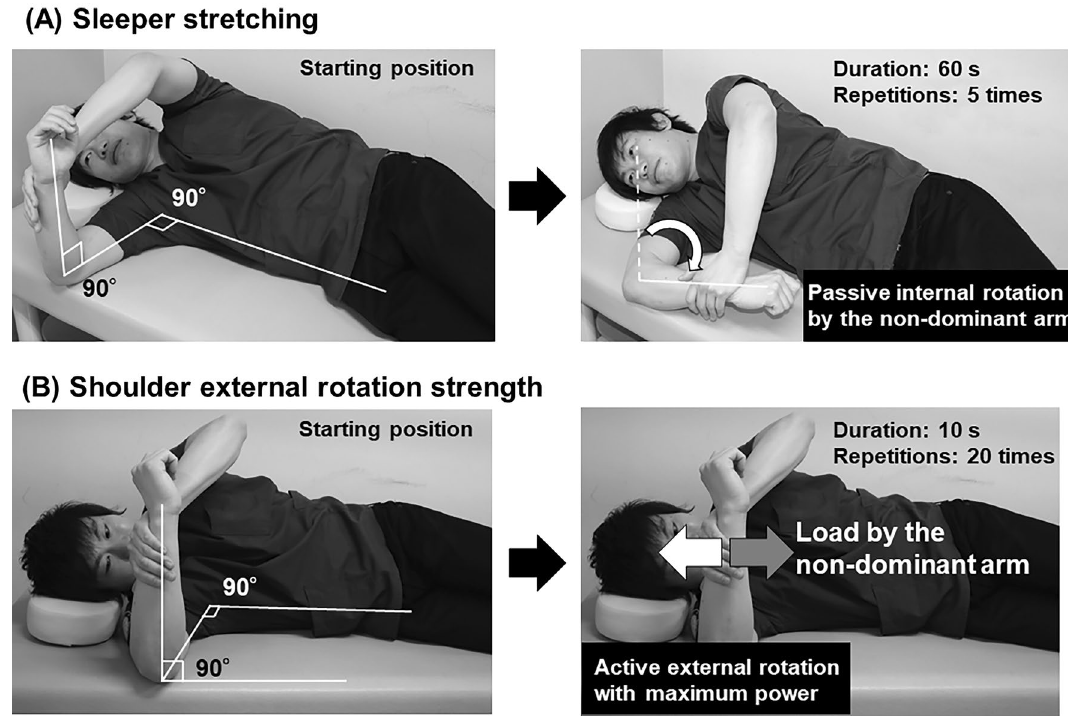
Figure 4. Prevention programs. ( a ) Sleeper stretching exercises: (1) The starting position is a dominant lateral position with the dominant scapula in contact with the bed, the dominant shoulder flexed to 90°, the dominant elbow flexed to 90°, and the dominant forearm in a neutral position. (2) The dominant forearm is grasped proximal to the dominant wrist with the non-dominant hand. (3) The dominant shoulder is passively and internally rotated by the non-dominant hand to the end of its maximum range of motion and that position is held for 1 min. (4) After a 30-s break, the stretching is repeated for a total of five times each night. ( b ) Shoulder external rotation strengthening exercises: (1) The starting position is the same as that of the sleeper stretch. (2) The dominant shoulder is maximally externally rotated for 10 s against an internal rotation force by the contralateral arm (isometric exercise). (3) After a 10-20-s break, the training is repeated for a total of 20 times each As this stretching program significantly decreased the incidence of shoulder and elbow injuries in a previous study 13 , it was used as an active control in the current study. Shoulder external rotation strength training. A modified strength training protocol focusing on the inner shoulder muscles, including the infraspinatus and teres minor 9 , and on the outer shoulder muscles, includ- ing the deltoid and the trapezius, was used as both the inner and outer muscles contribute to external rotation strength. The shoulder external rotation strengthening exercise is illustrated in Fig. 4b. The starting position is the same as that for the sleeper stretch. The dominant shoulder is maximally externally rotated for 10 s against an internal rotation force by the contralateral arm (isometric exercise). After a short break of 10–20 s, the training is repeated 20 times every night. Injury tracking. In this study, a shoulder or elbow injury was defined as any condition resulting in the pitcher being considered disabled for at least 8 days, excluding injuries due to external forces, such as being hit by a ball, colliding with another player, or falling 9,13,19–27 . Participants completed a questionnaire regarding the presence of shoulder and/or elbow pain, limitations to pitching caused by shoulder or elbow pain, and the pres- ence of other injuries each day to record the timing of injuries and avoid recall bias. The participants’ responses were submitted to the researchers monthly. Furthermore, to confirm that the participants completed the daily questionnaires, they were contacted via telephone once or twice per month. Dropout was defined as when the participants did not complete the questionnaire once or when the compliance rate of the assigned exercise pro- gram was lower than 66.6% as this study included a time-to-event analysis. Statistical analyses. All statistical analyses were conducted using SAS version 9.4 (SAS Institute Inc., Cary, NC, USA). All tests, with the exception of the NI test, were two-sided with a significance level of P = 0.05.